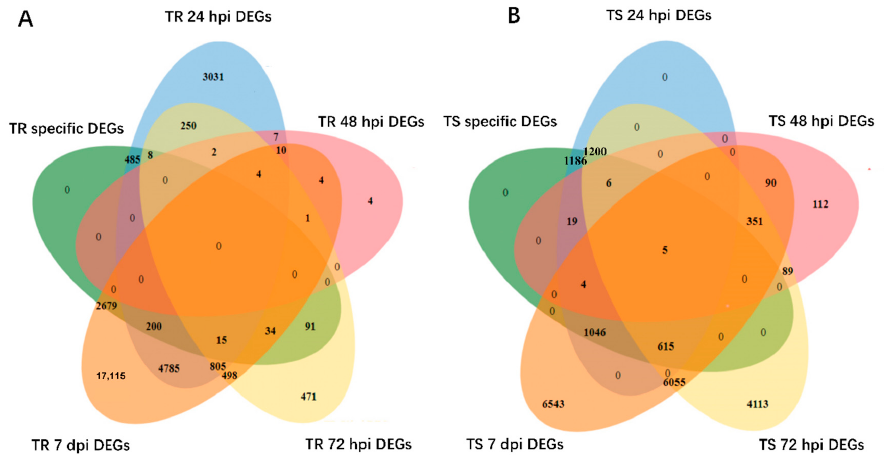
Figure 7. This Venn diagram presents the DEGs of clonal line type-specific transcriptional changes. ( A ) Specific DEGs of resistant clonal line at four time points. ( B ) Specific DEGs of susceptible clonal line at four time points. TR specific DEGs: specific DEGs of resistant clonal line induced by F. proliferatum L1 at four time points; TS specific DEGs: specific DEGs of susceptible clonal line induced by F. proliferatum L1 at four time points.